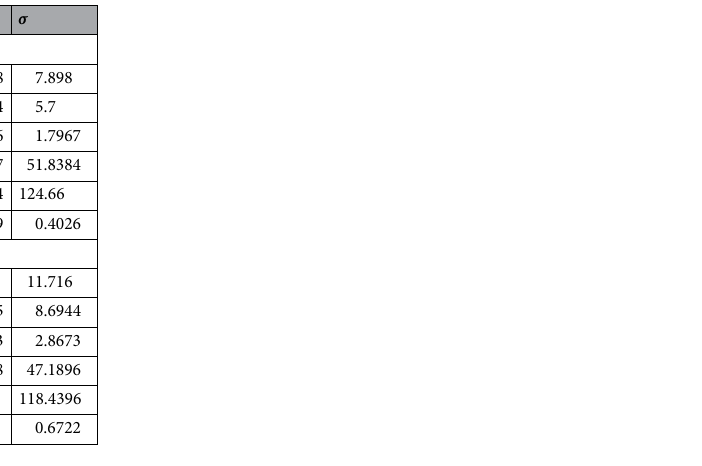
Table 10. Total packet loss outputs of metaheuristics on F 2 and F 6